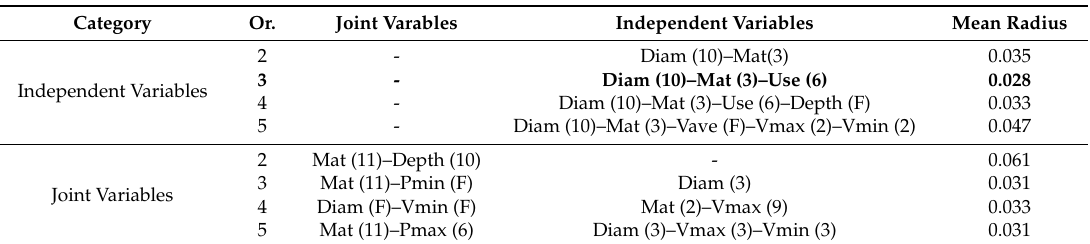
Table 6. Best predictive models: Trunk mains. Values in parenthesis represent the number of intervals considered in variable discretization (F stands for full